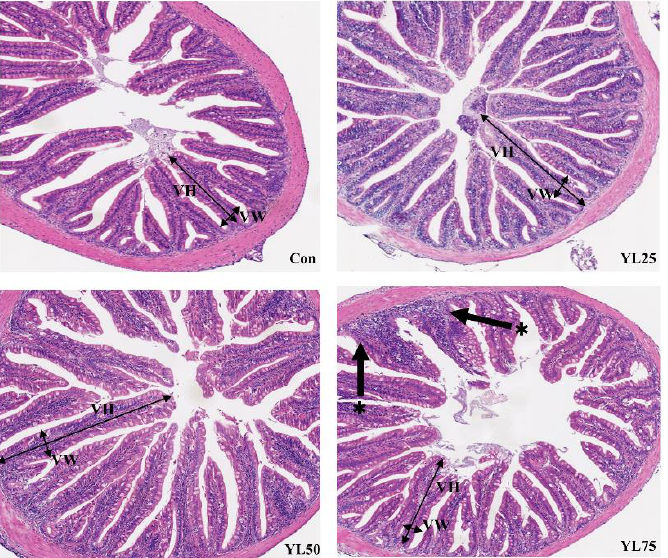
Figure 2. The mid-intestinal histology in largemouth bass fed different YL inclusion diets for 28 days. Magnification ×200. Black asterisks represent distorted crypt structure in intestine mucosa. Black thick arrows represent the villus height (VH) and villus width (VW). Con was the control diet. In the other three diets, 25%, 50%, 75% of the fish meal was replaced with YL. The three diets were named YL25, YL50, and YL75, respectively. Table 3. Histological parameters of mid-intestinal in juvenile largemouth bass fed different YL in- clusion diets *.